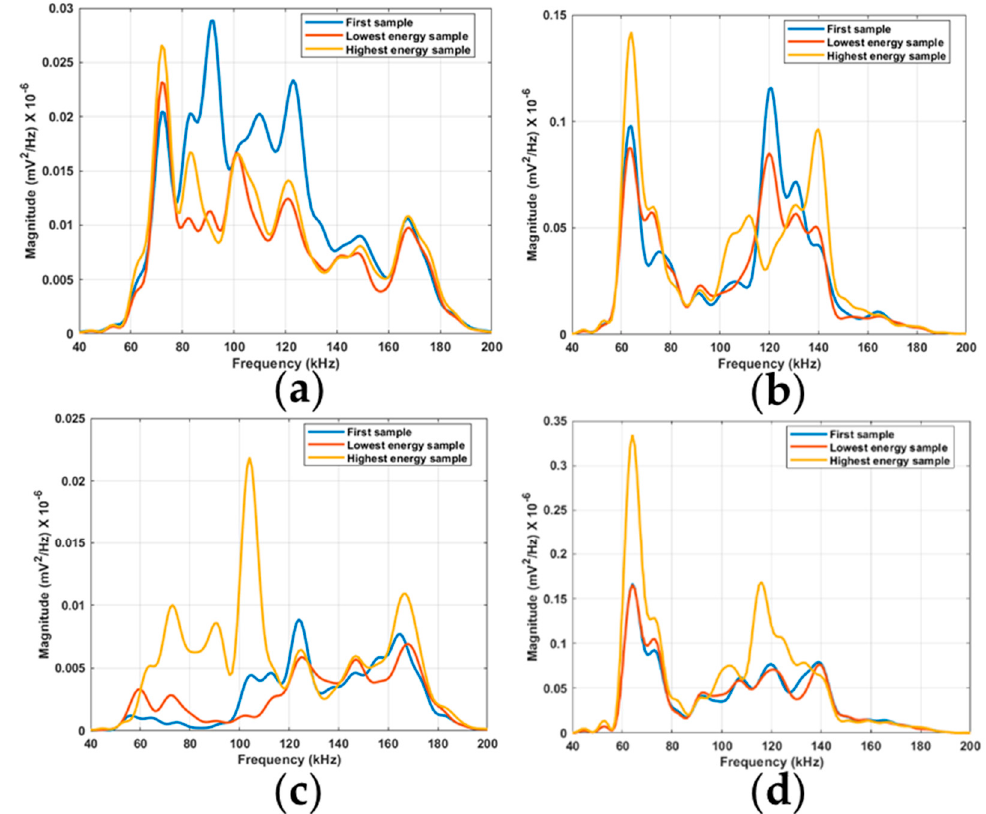
Figure 12. PSD response of RTF tests 1 to 4 for the first, the lowest energy, and the highest energy samples: ( a ) test 1; ( b ) test 2; ( c ) test 3; ( d ) test 4. samples: ( a ) test 1; ( b ) test 2; ( c ) test 3; ( d ) test